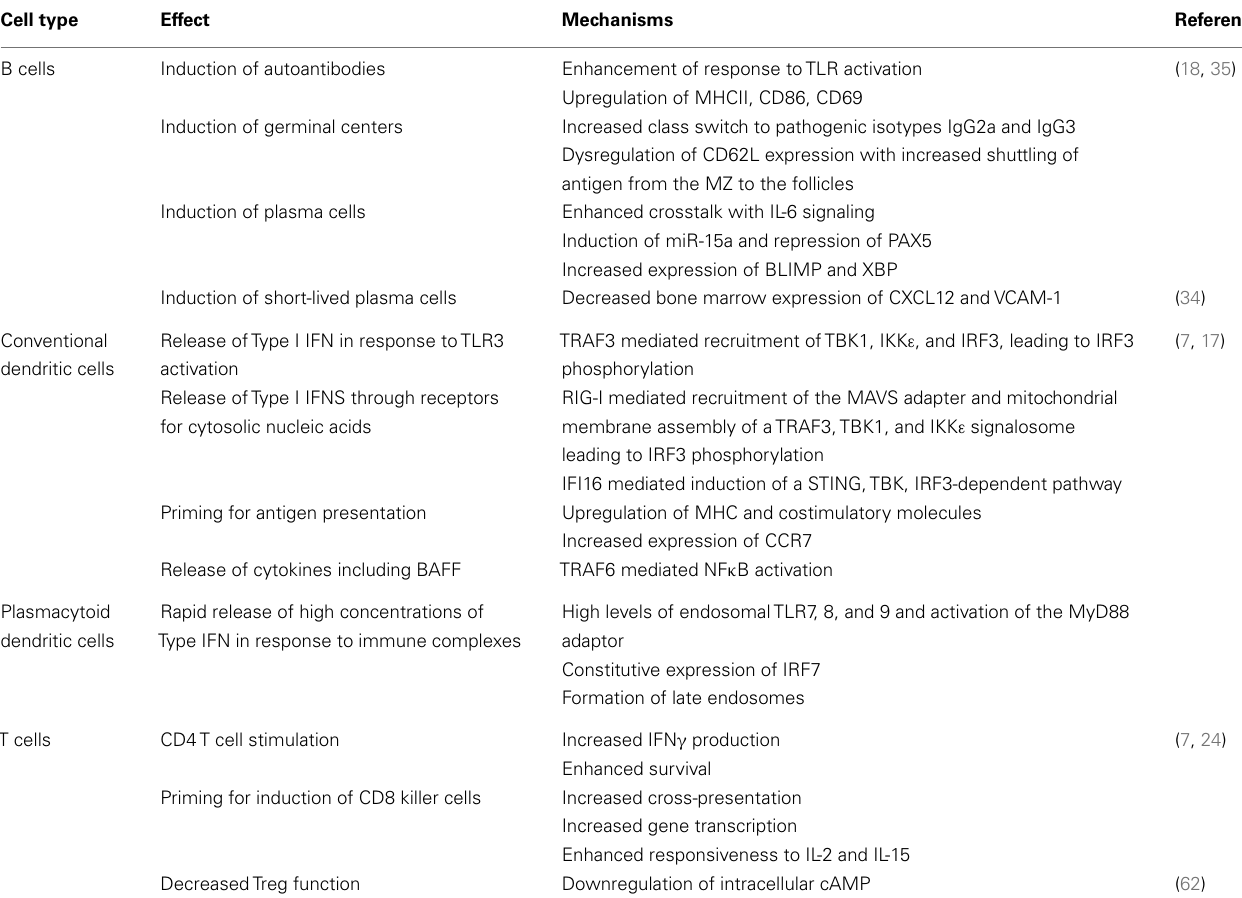
Table 1 | Induction and pro-inflammatory effects of Type I